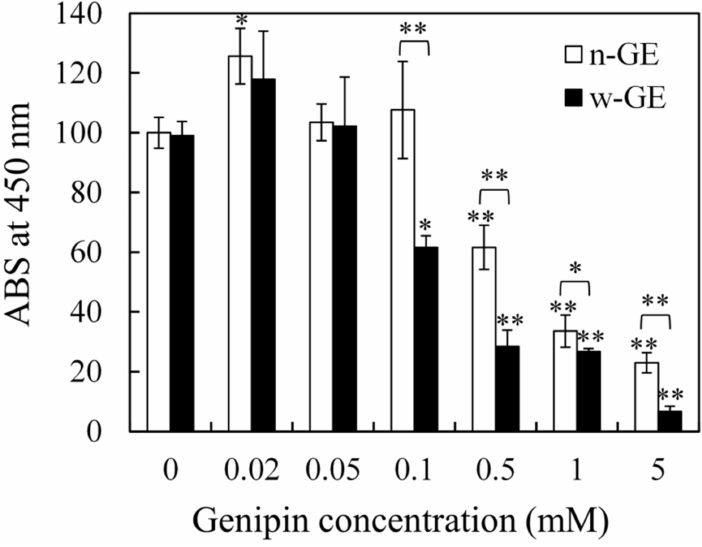
Figure 4. Results of acute cytotoxicity tests for w-GE and n-GE using a WST-8 assay. In this assay ABS at 450 nm reflects the numbers of viable V79 cells, which were in contact with genipin